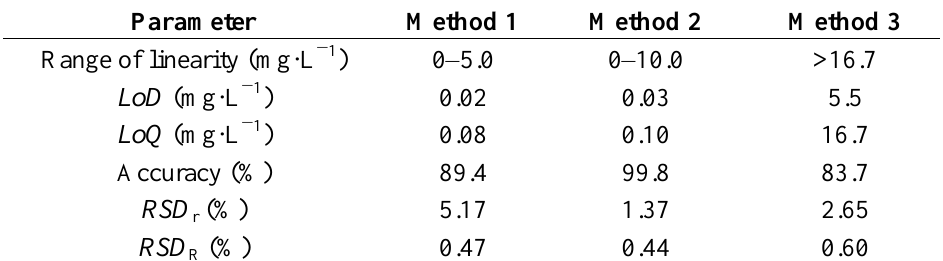
Table 2. Results obtained in the validation study.